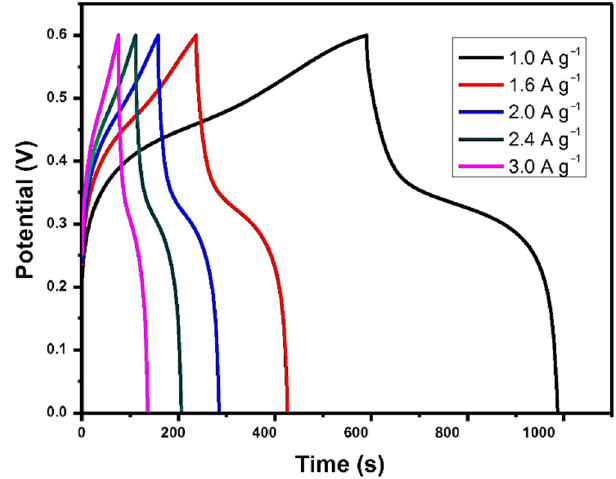
Figure 12. Galvanostatic charge/discharge curves of CoMoS 4 . Reproduced with permission from Xiaoyang Xu, Amorphous CoMoS 4 for a valuable energy storage material candidate; published by Elsevier, 2016 [161] .